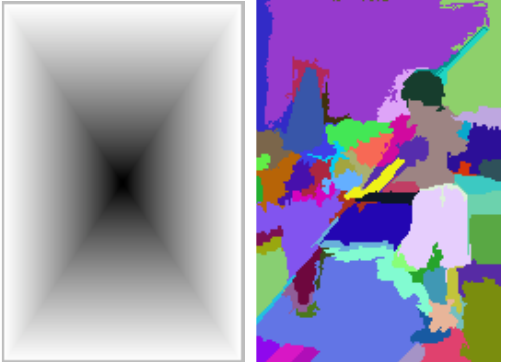
Figure 3. Visualization of the two prior constraints. Left: center prior with the term [ − 1 + 2max ( .,. )] of Equation (13) (with convention − 1: black and 1: white). Right: region prior given by a superpixel segmentation